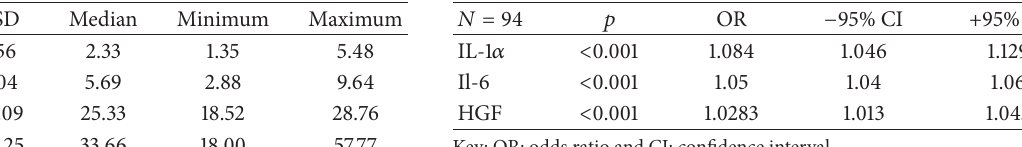
Table 5: IL-6 concentration (pg/mL) in the serum of alcoholics and healthy controls.